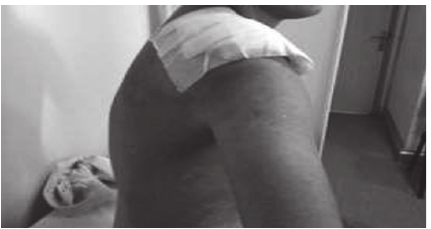
Figure 5: The regression after combination